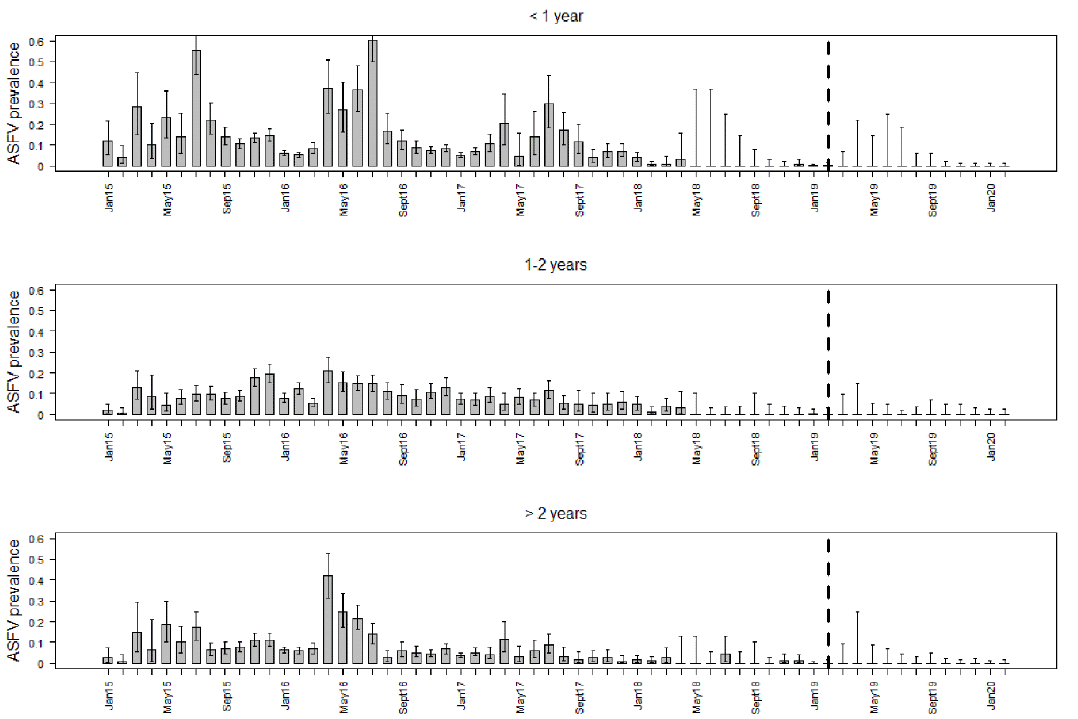
Figure 1. Prevalence estimates for ASFV PCR-positive wild boar, irrespective of their serological status for each study month and three different age classes. The whiskers indicate 95% confidence intervals. The broken vertical line highlights February 2019, when ASFV-positive wild boar were last detected by PCR.